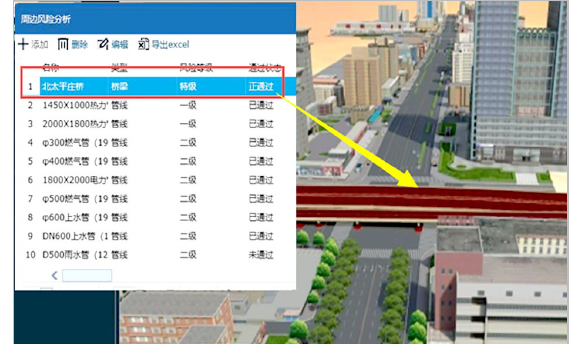
Figure 17. Position risk engineering and view of the monitoring data